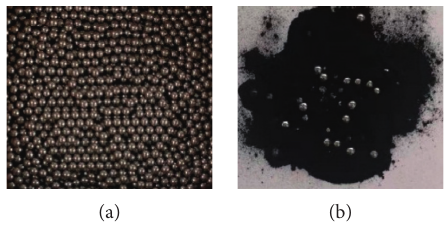
Figure 19: Equivalent filling material for liquid. (a) Lead balls. (b) Mixture of lead balls and iron powder.